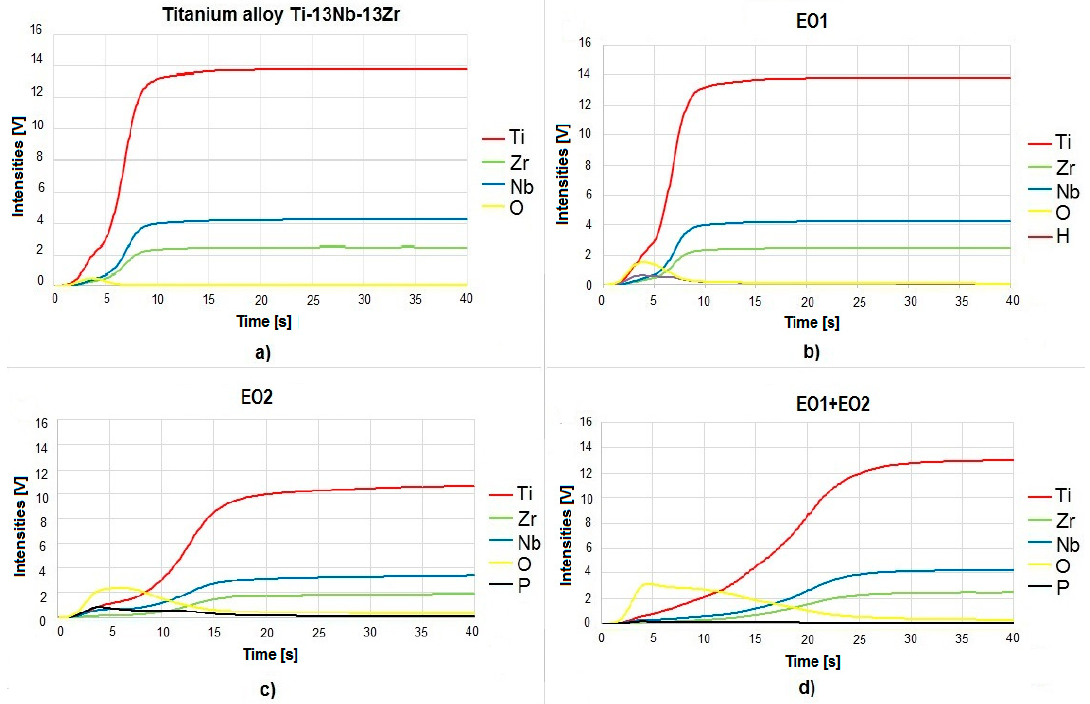
Figure 5. Glow discharge optical emission spectroscopy (GDOES) analysis results. ( a ) Ti–13Nb–13Zr alloy; ( b ) alloy after EO1 treatment; ( c ) alloy after EO2 treatment; ( d ) alloy after EO1 + EO2 treatment.